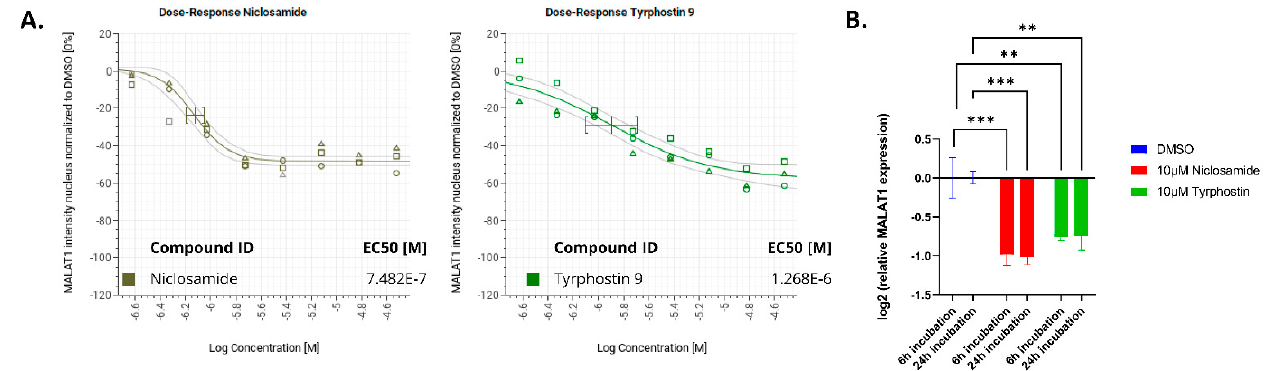
Figure 4. ( A ): EC50 determination of Niclosamide and Tyrphostin 9 for nuclear MALAT1 staining reduction after 2h incubation. Data normalized to DMSO control (0). ( B ): MALAT1 RNA expression levels relative to DMSO control. GAPDH was used as normalization control. Mean +/ − SEM (n = 6). *** p value < 0.001; ** p value < 0.01.